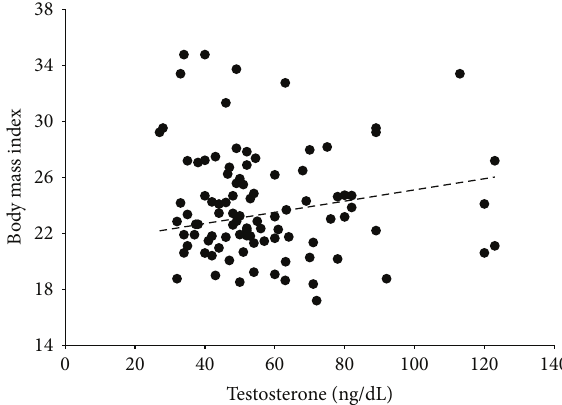
Figure 2: Change in body mass index in relation to salivary testosterone concentrations in women in the nonfertile days of the menstrual cycle. Body mass increased significantly along with testosterone levels ( 𝑃 = 0.023